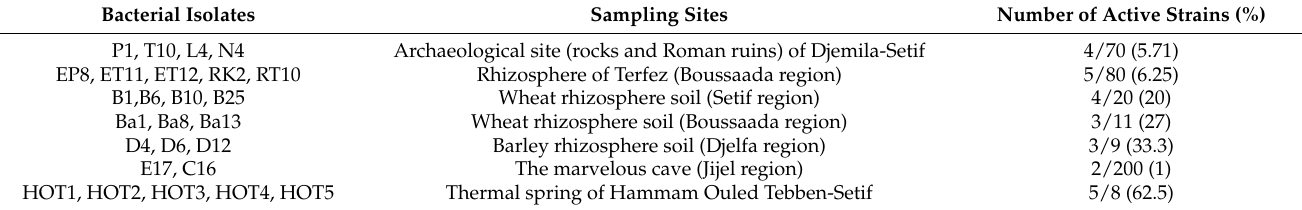
Table 1. Selected bacterial isolates ( n = 26) with cellulase activity from various environments.